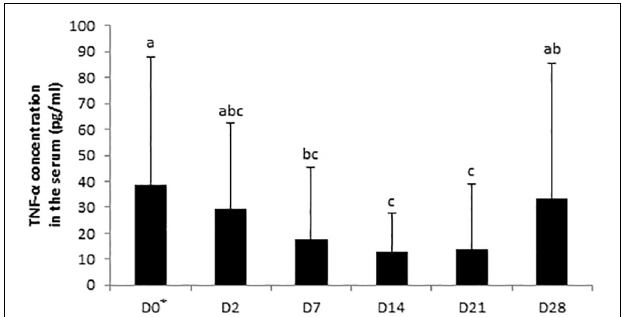
FIGURE 7 | Variations in TNF- α concentrations in serum samples of horses subjected to an oral challenge with TMS from D0 to D4 by day. Means with different superscripts differ at P < 0.05. ∗ D0: Basal value before the first TMS